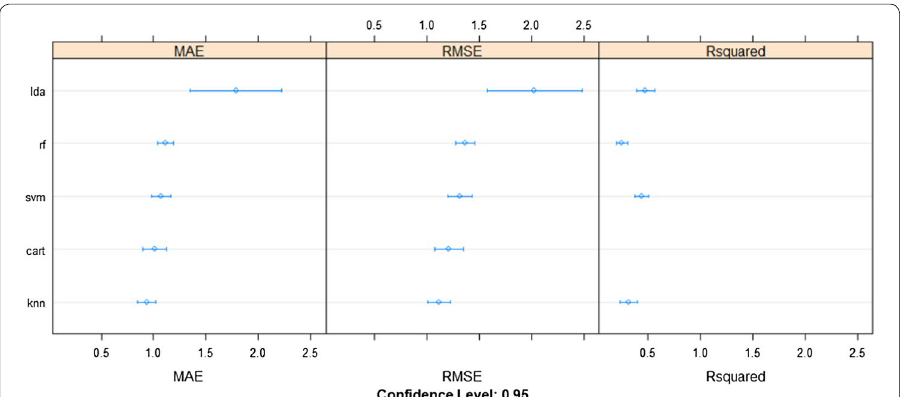
Fig. 3 Performance of the five models applied to Pedro Sanchez candidate